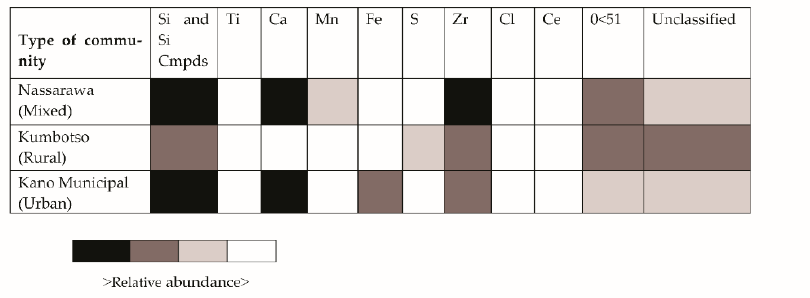
Figure 8. The classified particles are divided into four groups based on settlement: ( a ) urban, ( b ) mixed, and ( c ) rural ( d ) A Comparism diagram of the ratio of Si fiber to sand fibres for all sites.